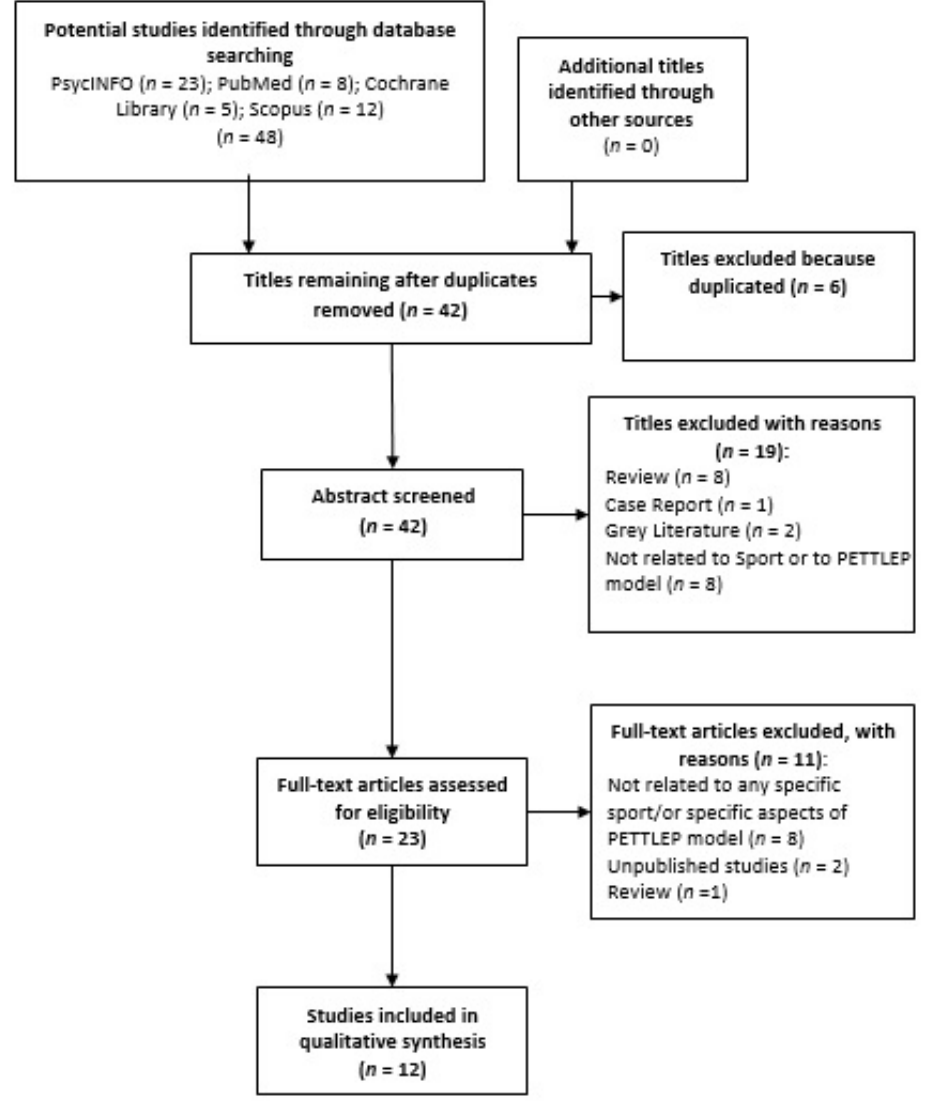
Figure 1. Flow chart of the review performed in accordance with PRISMA statement.